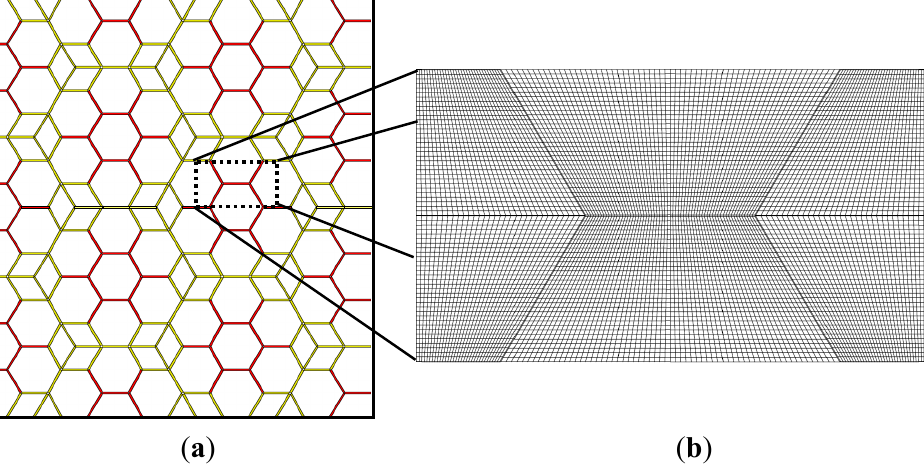
Figure 3. ( a ) 2D model of a cross-section of the hierarchical cellular polycrystalline material (cohesive zone model (CZM) interface elements of the interfaces of the levels 1 and 2 are shown in red and green, respectively); ( b ) Detail of the finite element (FE)